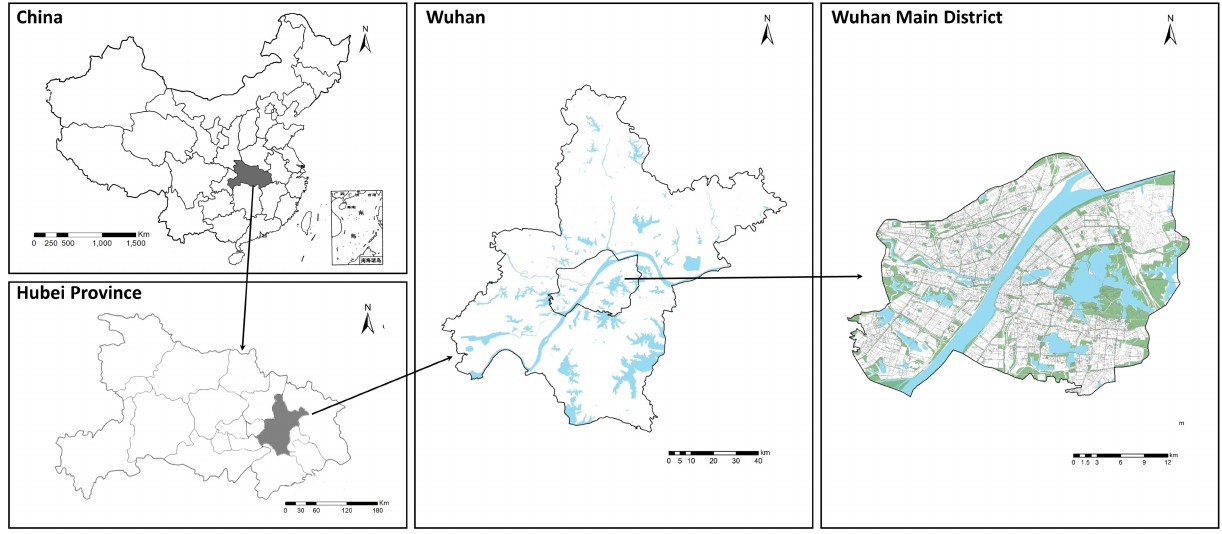
Figure 1. Wuhan city and main urban area location.